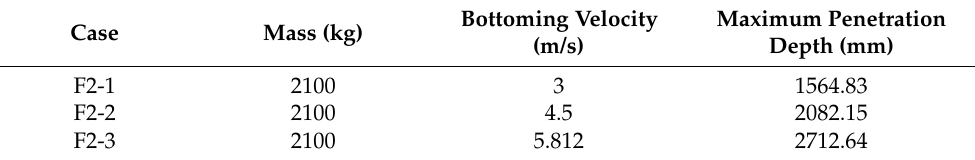
Table 7. The maximum penetration depths with different bottoming velocities. Bottoming Velocity Case Mass (kg)